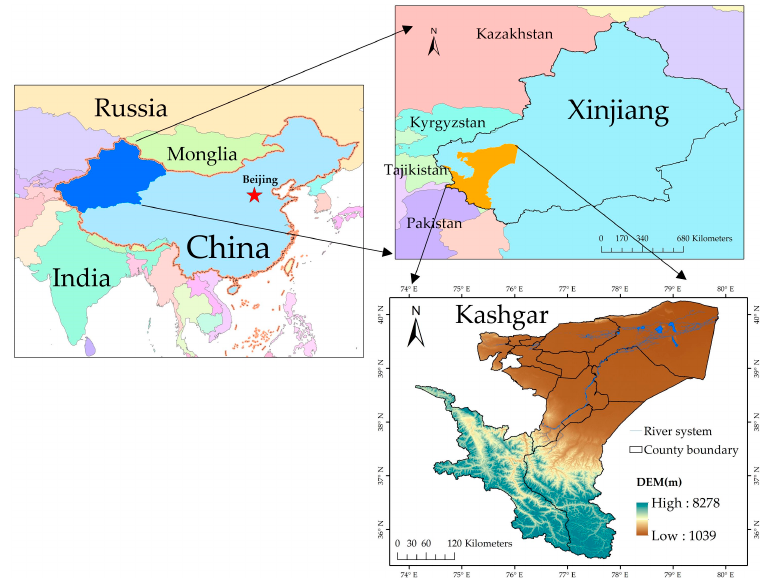
Figure 1. Geographic location of the study area.